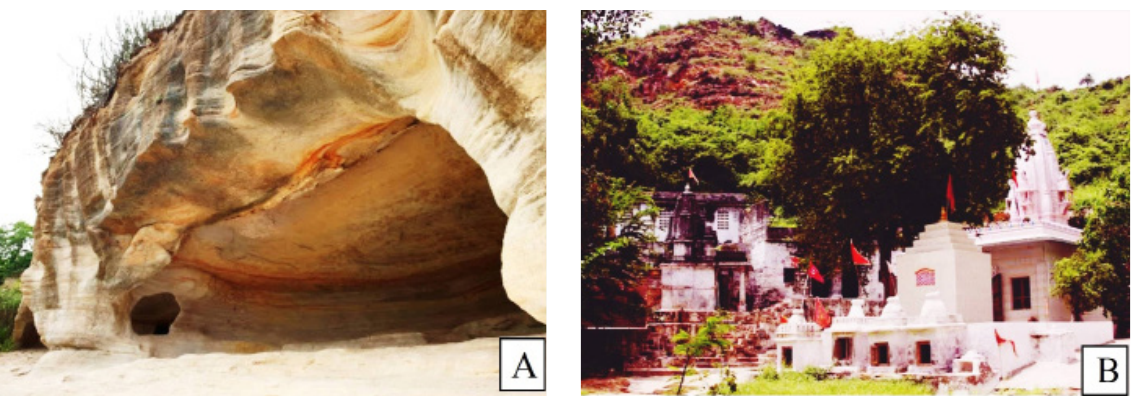
Figure 7. Tapkeshwari Temple rock cave. A) Rock cave on top of the hill near the Tapkeshwari Temple. B) Tapkeshwari Temple.